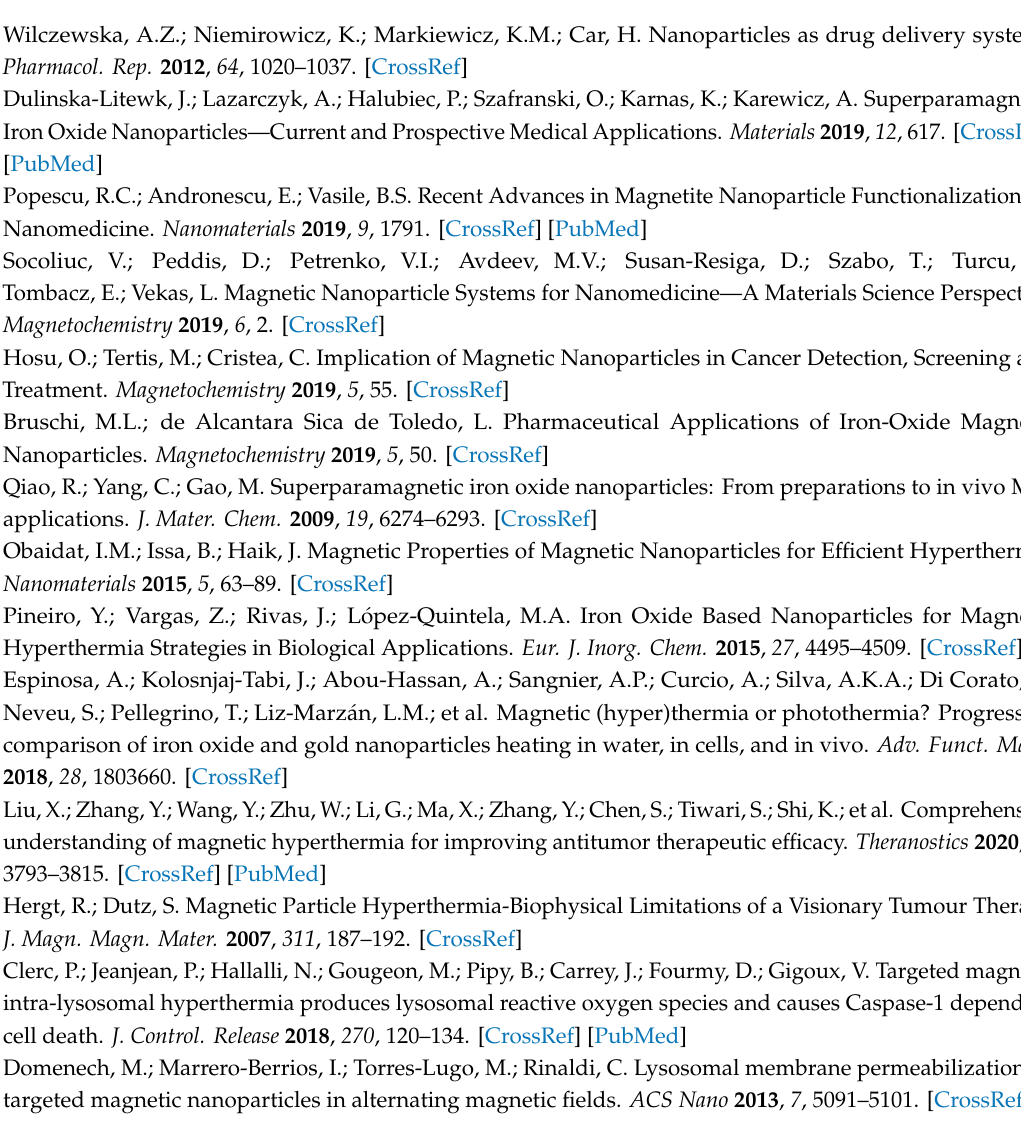
MagNP4 dispersed in water and PEG8k, Figures S10 and S11: Heating curves of MagNP4 internalized in A549 and HGF, Figure S12: The SAR values of MagNP4 for three di ff erent values of H recorded in PEG8k and in both cells, Table S1: Amount of Fe 3 + internalized in cells relevant for in vitro cytotoxicity assays and Fe 3 + concentration of samples used in in vitro magnetic